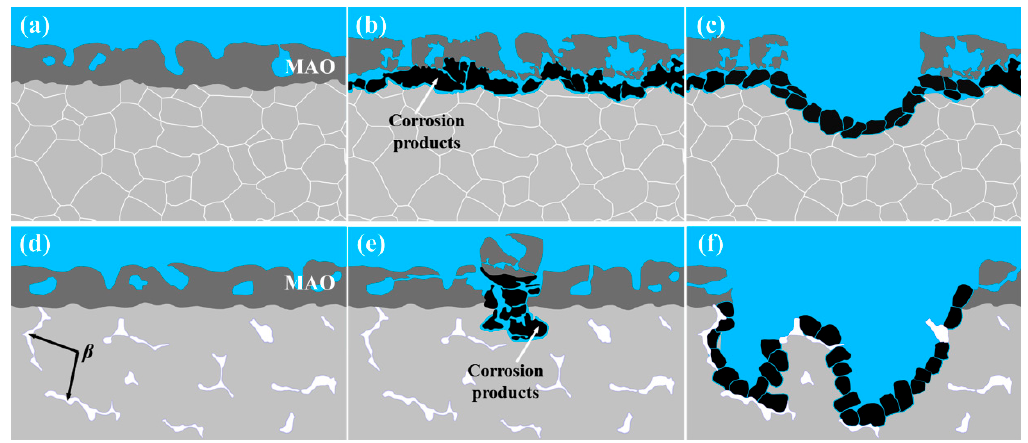
Figure 12. Schematic diagrams for the failure processes of MAO coatings on AZ31 ( a – c ) and AZ91 ( d – f ) alloys.